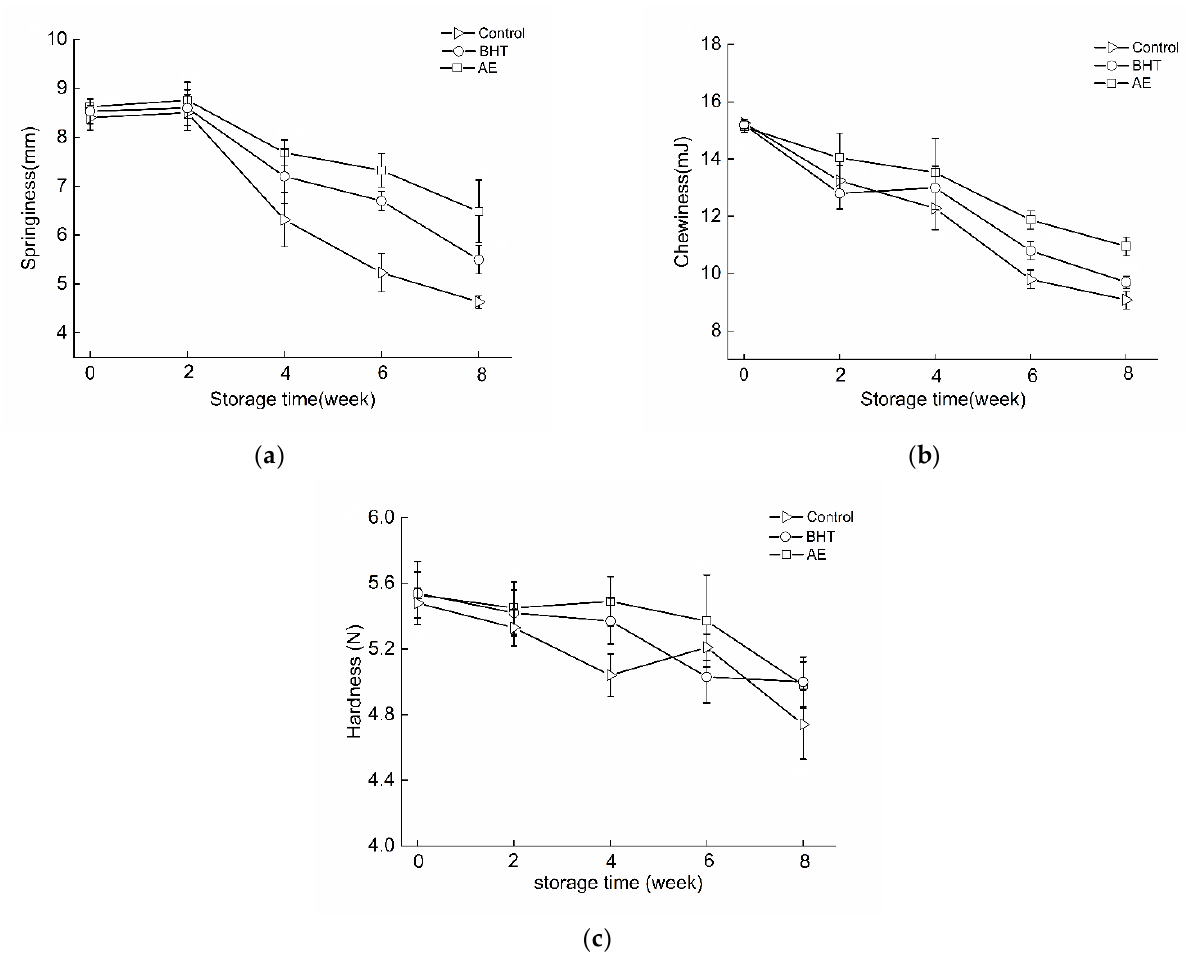
Figure 5. Changes in springiness ( a ), chewiness ( b ), and hardness ( c ) of shrimp surimi products with AE, BHT, and control during frozen storage.